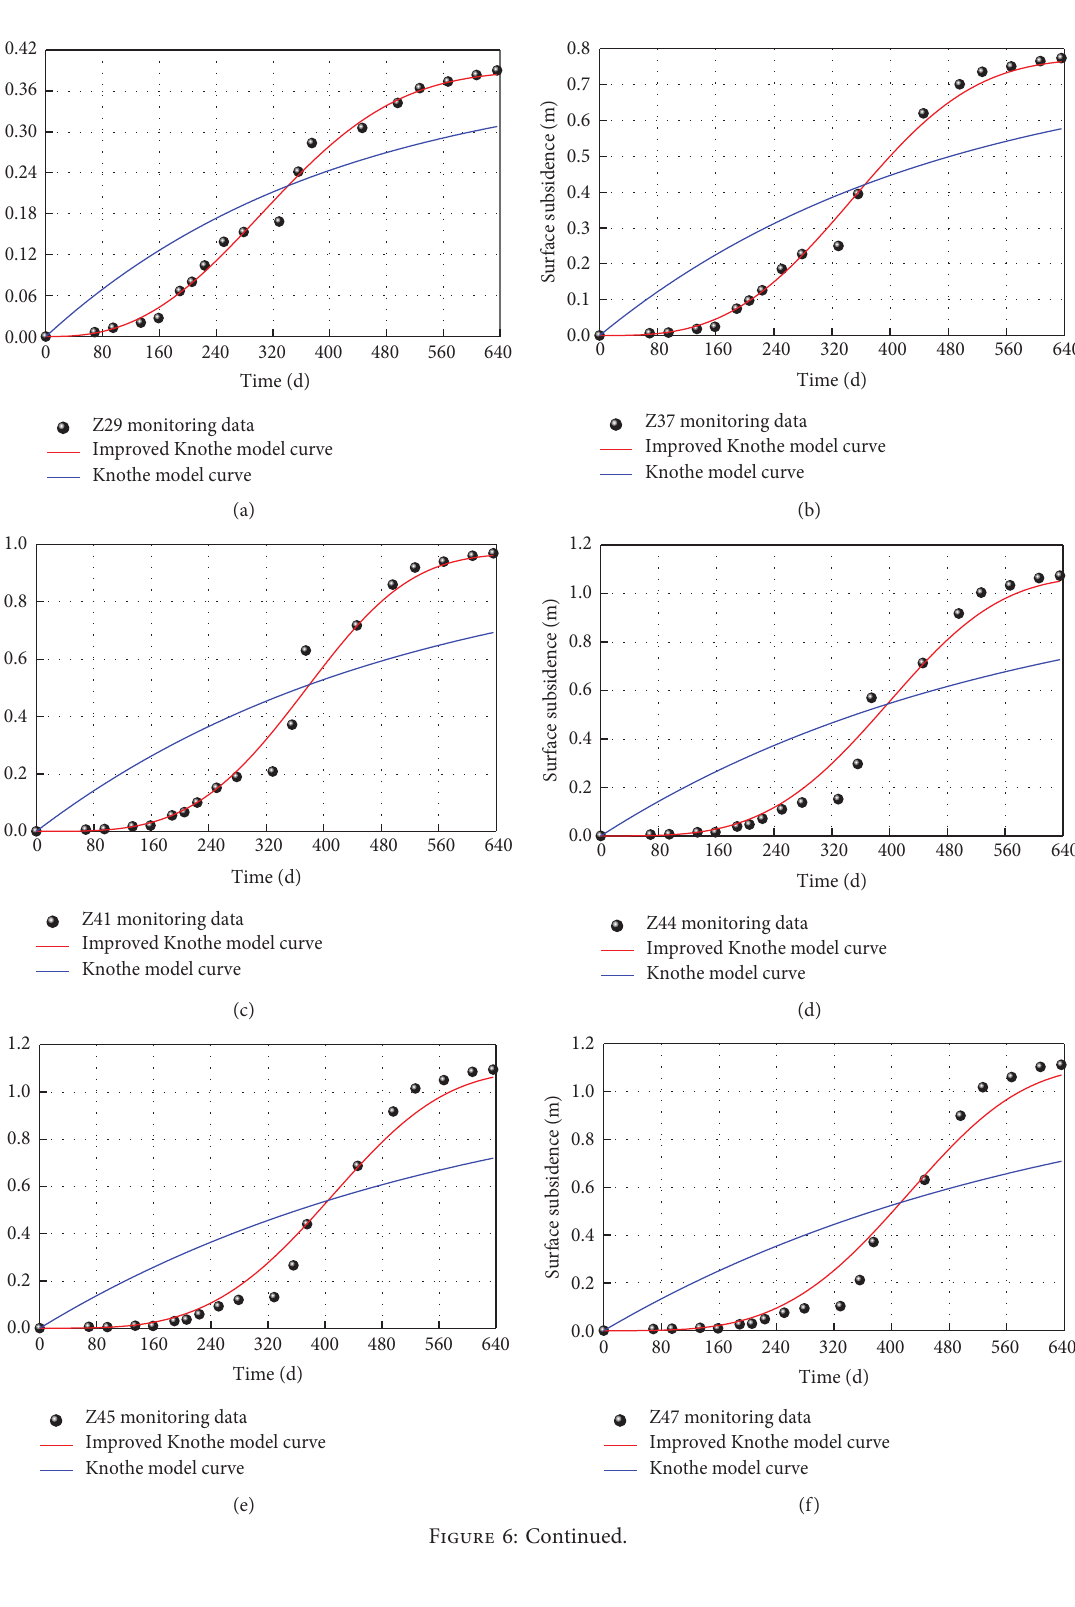
Z47 monitoring data Improved Knothe model